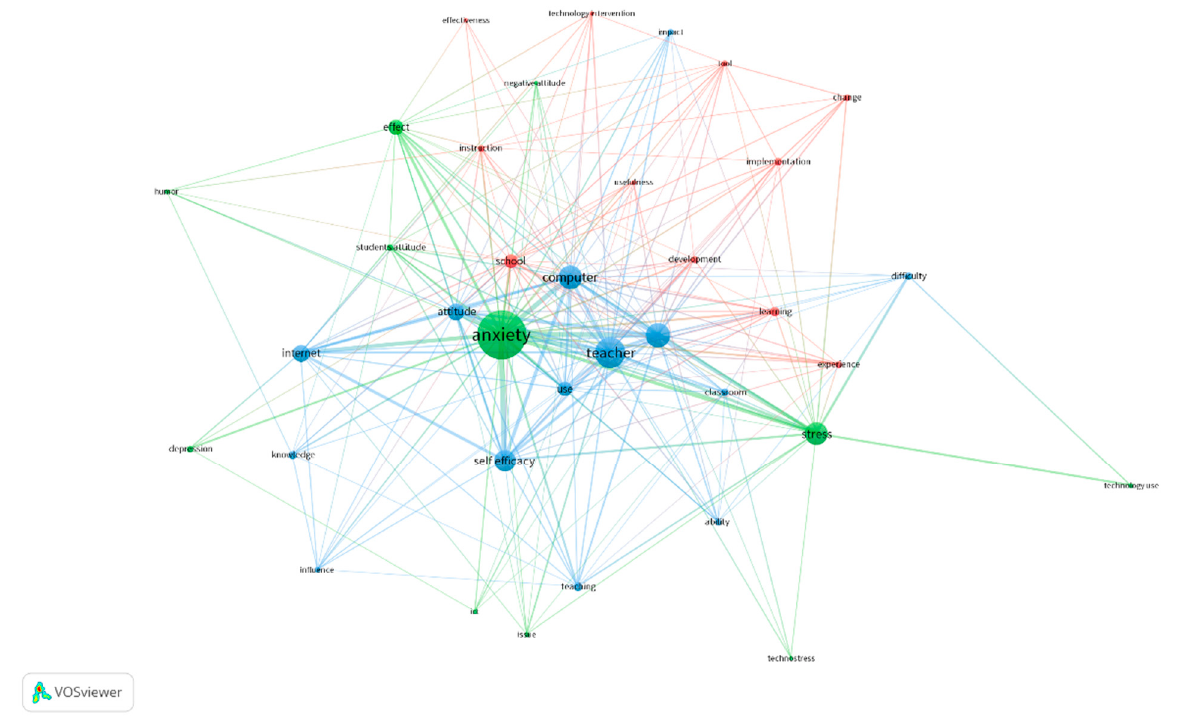
Figure 4. Bibliometric map of the 36 KeyWords Plus (KW+) representation.